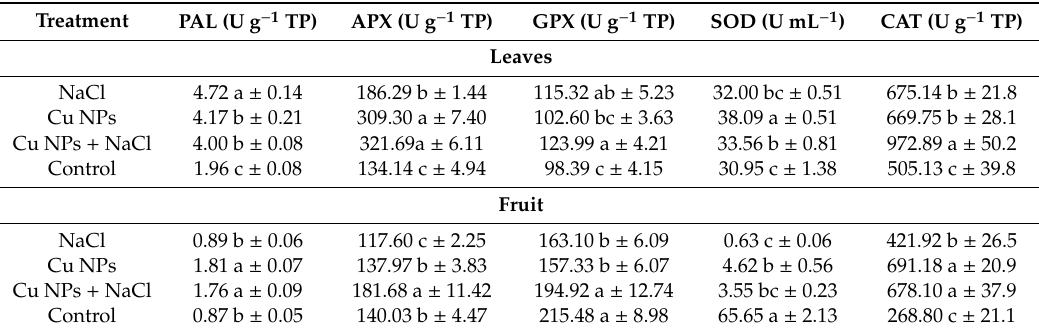
Table 4. Enzymatic activity in the leaves and fruit of tomato plants with foliar application of Cu NPs and saline